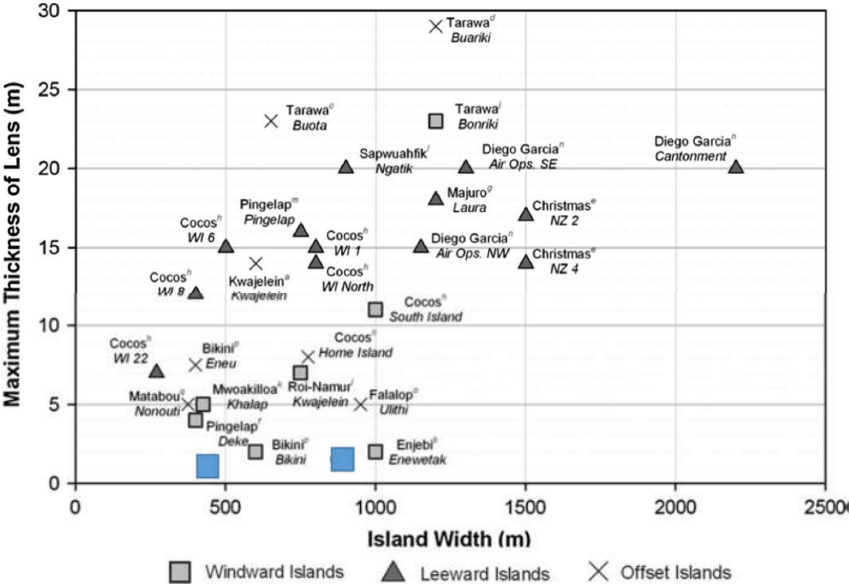
Figure 9. Evolution of the maximum thickness of the freshwater lens as a function of the atoll width for different Pacific atolls according to ref. [16]. Blue squares correspond to two motus (Vignes motu and Avatoru motu) of the Rangiroa atoll.